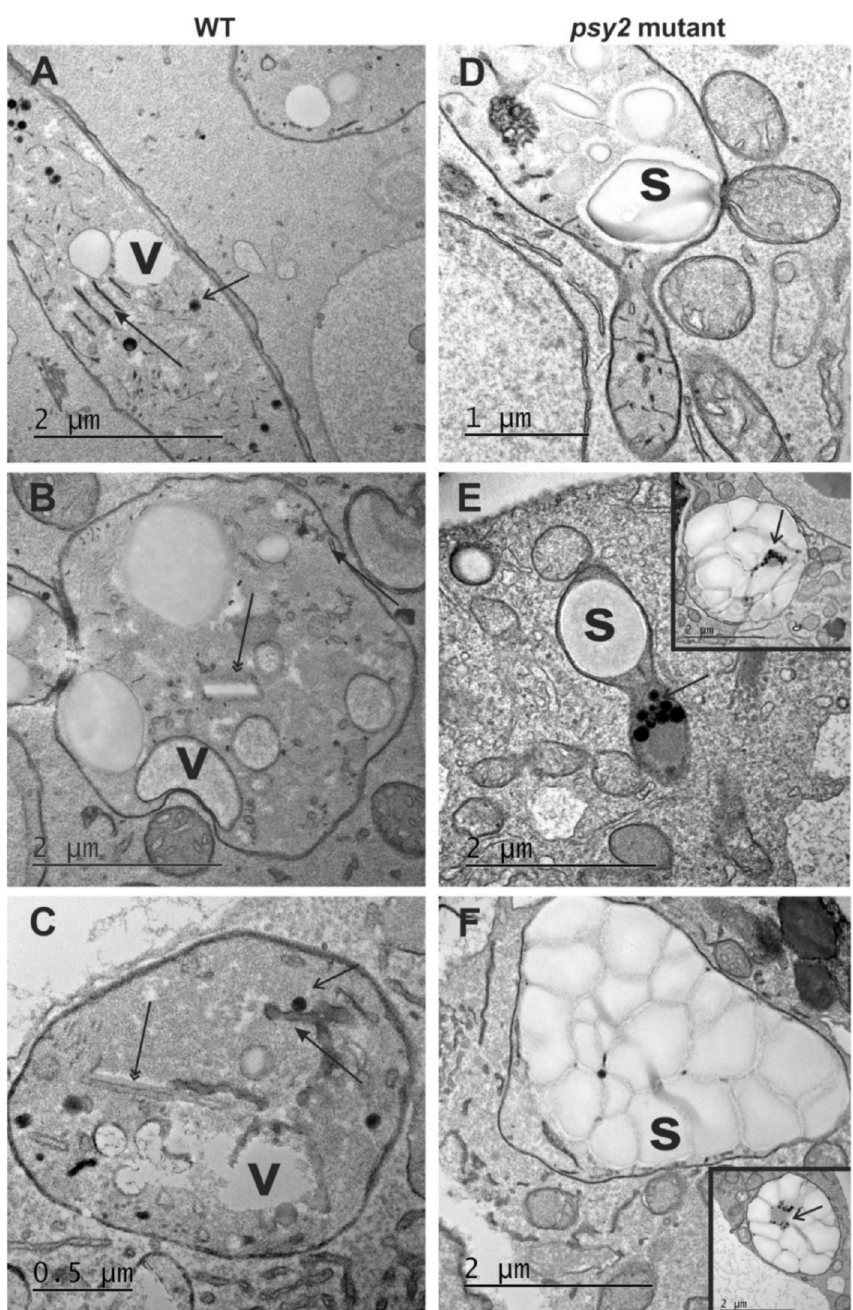
Figure 4. Plastid ultrastructure in callus cells of ( A – C ) the WT (not transformed control) and ( D – F ) psy2 mutant. ( A ) Early stage of chromoplast differentiation in WT with plastoglobuli and internal membranes. ( B ) Chromoplast with a well visible carotene crystal. ( C ) Chromoplast with a carotene crystal, numerous plastoglobuli, internal membranes, and vacuoles. ( D ) Plastid in the psy2 mutant callus cells with simple ultrastructure with the prominent starch grains, some plastoglobuli, and a few internal membranes. ( E ) Plastid with the single prominent starch grain and numerous plastoglobuli (inset–an example of amylochromoplast with numerous starch grains and plastoglobuli). ( F ) A plastid completely filled with starch grains surrounded by numerous mitochondria (inset–an example of plastid filled with the starch grains and numerous plastoglobuli). v-vacuole; s-starch grain; arrow-area with internal membranes; open arrow-plastoglobuli; double arrow-carotene